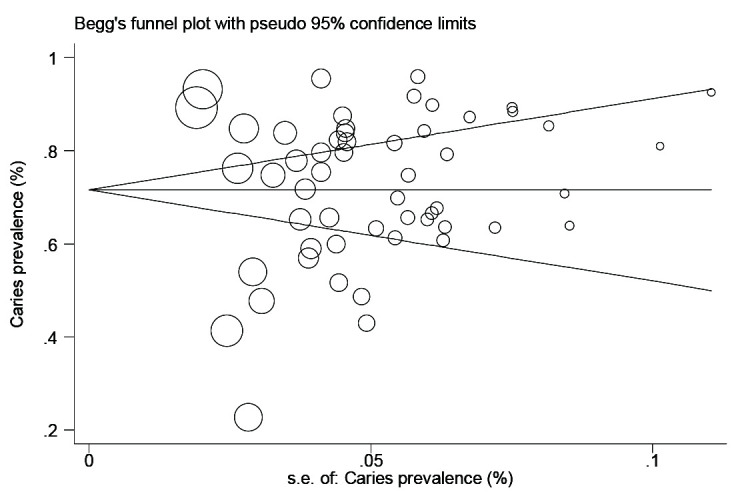
 The mean of dmft index in Iran based on random effects model. The midpoint of each segment is the estimate of prevalence and segment lengths show the 95% CI for each study.
The diamond mark shows the prevalence in the country for all studies.